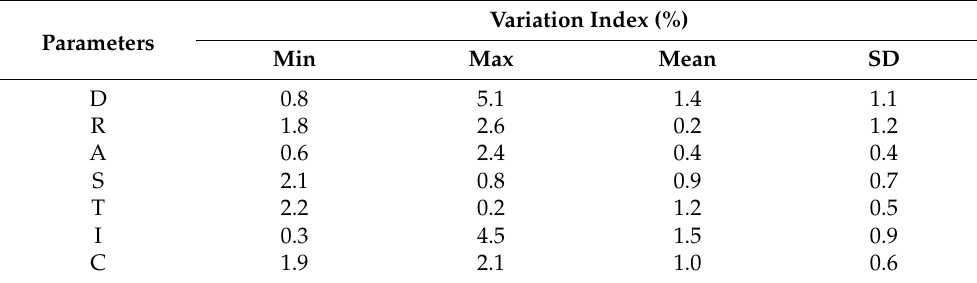
Table 4. Statistical summary of one-map-removal sensitivity